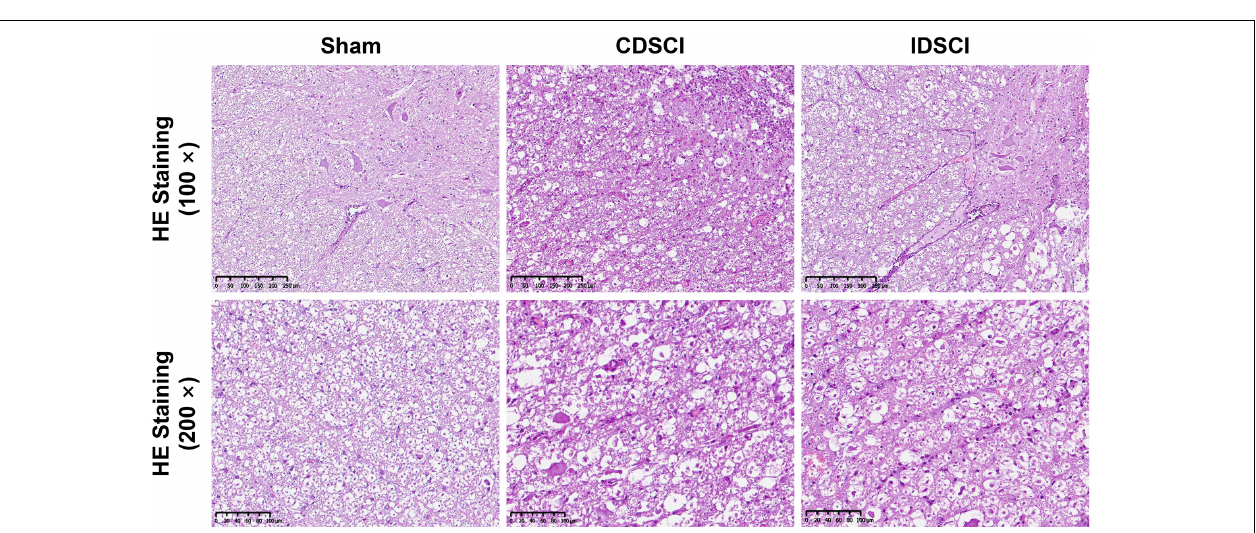
occurred when the hind limbs were stimulated by squeezing ( Figures 2B,C ). The assessment results of the Tarlov score and ILMS score at the 1, 3, and 7 days after DSCI was